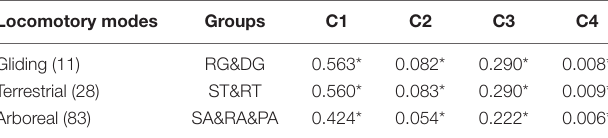
TABLE 1 | The C-metrics analyses of three locomotory modes (C1–C4 metrics). Locomotory modes